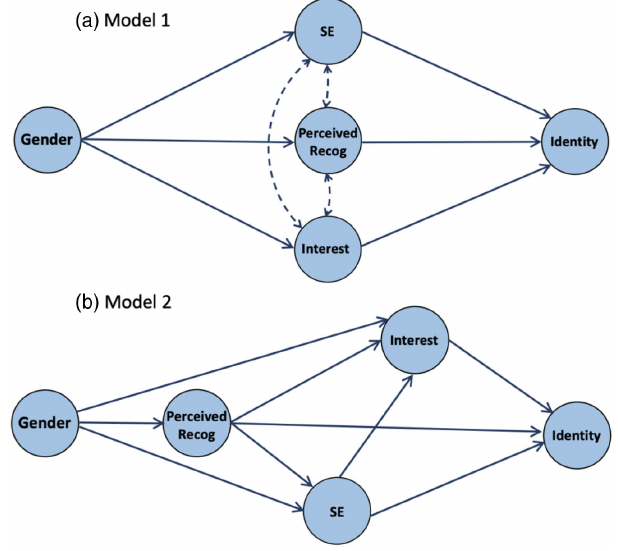
FIG. 1. Schematic representation of the path analysis part of the SEM models that shows how the relationship between gender and physics identity is mediated by perceived recognition (recog), self-efficacy (SE), and interest. (a) In model 1, all the three predictors are correlated with each other. (b) In model 2, perceived recognition predicts self-efficacy and interest, and self-efficacy predicts interest. The direct path from gender to identity is not shown because it is not statistically significant in both models for both